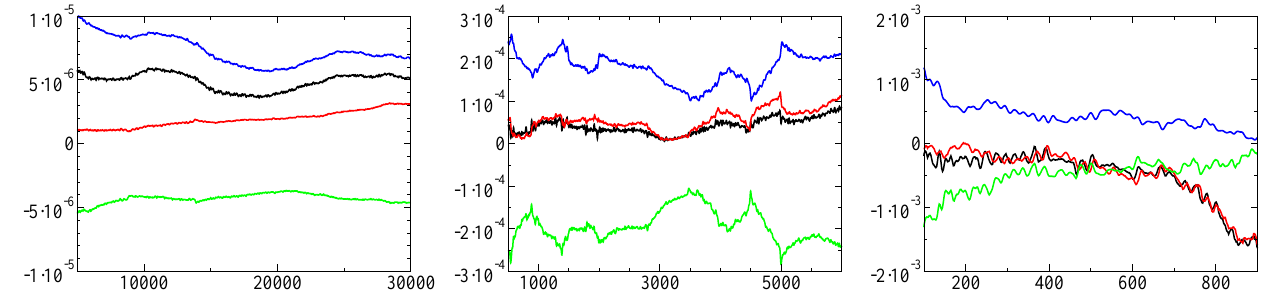
Fig. 5. Time evolution of the r.h.s. (black) of the equation for µ k together with the various contributions: gyrotropic heat fluxes (blue), Hall effect (green), non-gyrotropic pressure (red), for the same simulations as in Fig. 2: β = 0 . 3 and d i /l f = 0 . 020 (left), d i /l f = 0 . 080 (middle), and d i /l f = 0 . 16